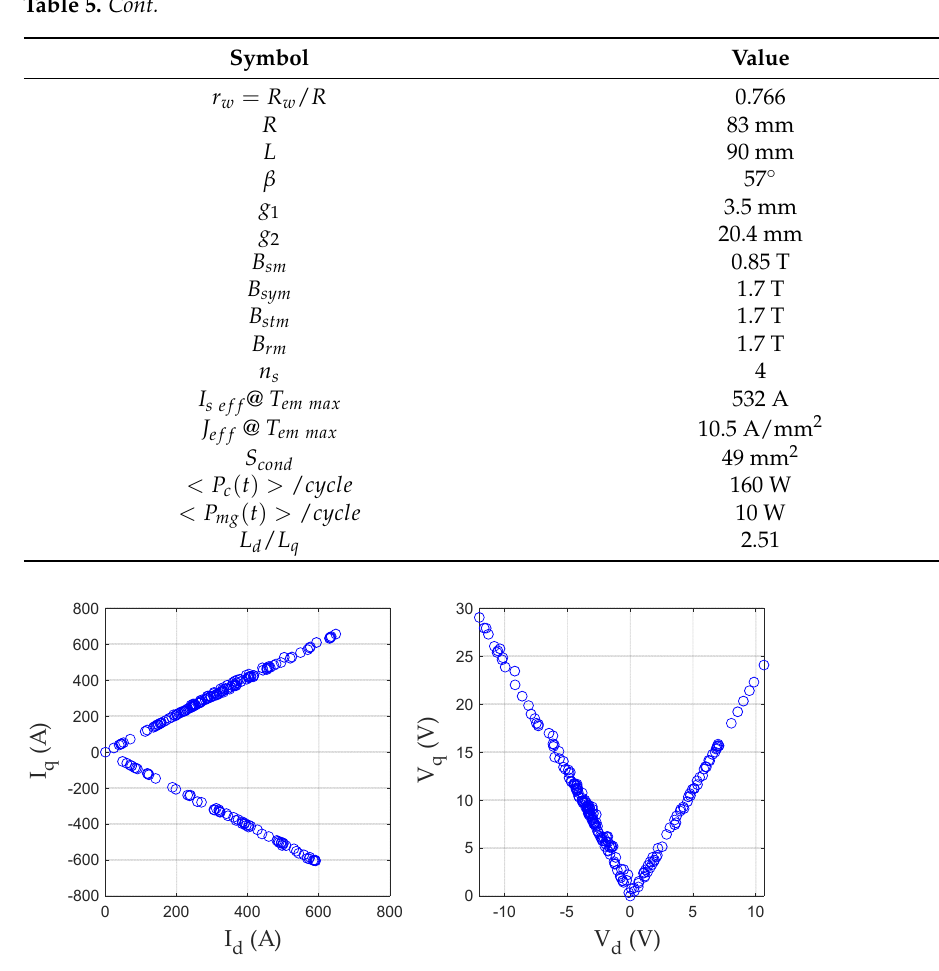
Figure 9. Locus of optimal d ‐ q axis stator currents and voltages during one cycle.